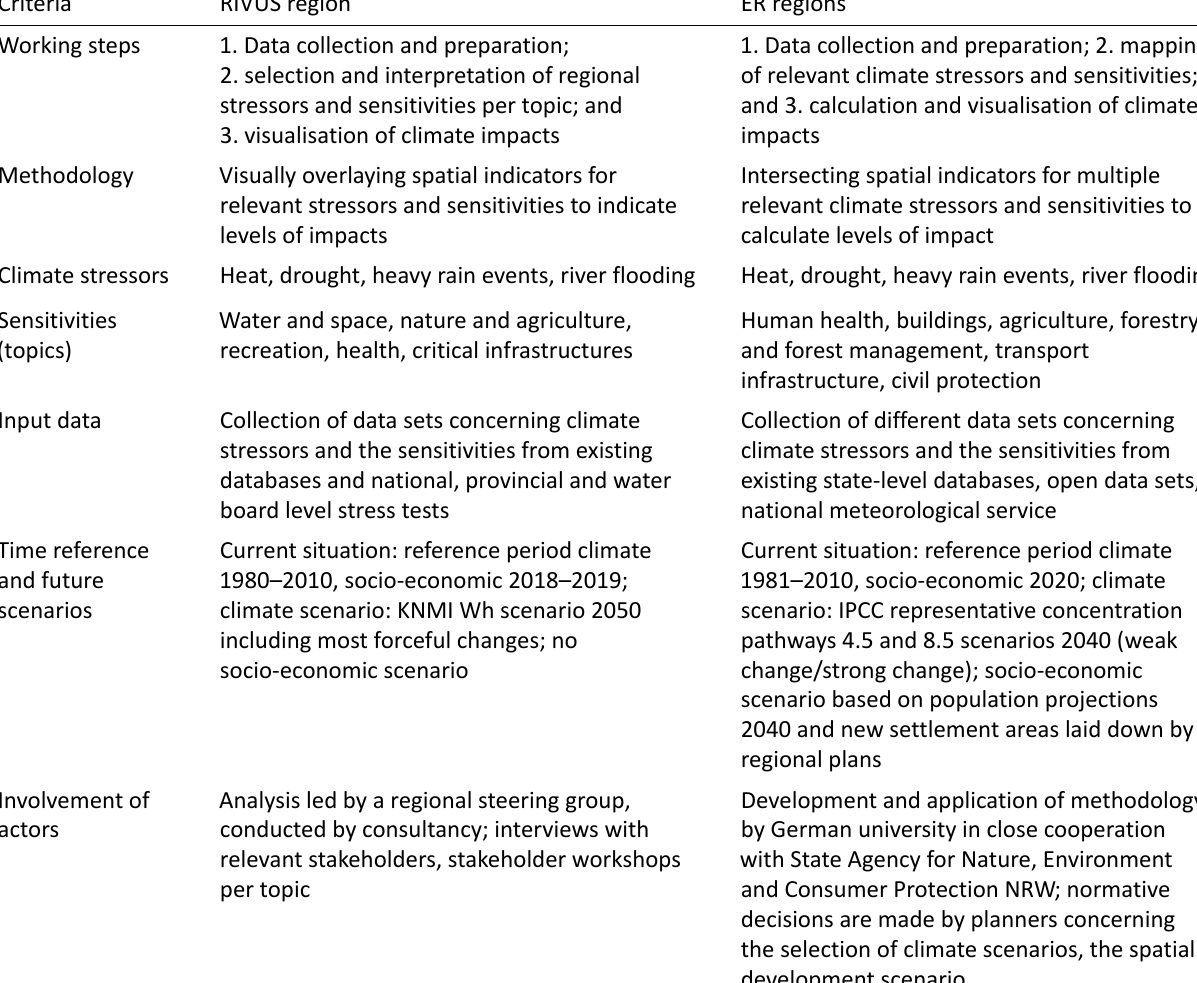
Table 3. Overview of the comparison criteria of the input.